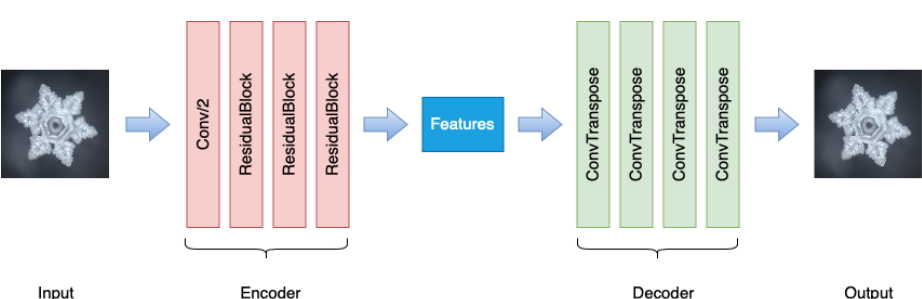
Figure 2. A residual auto-encoder model to extract features from origin images. Each residual block is a combination of a Downsample block and a regular block,